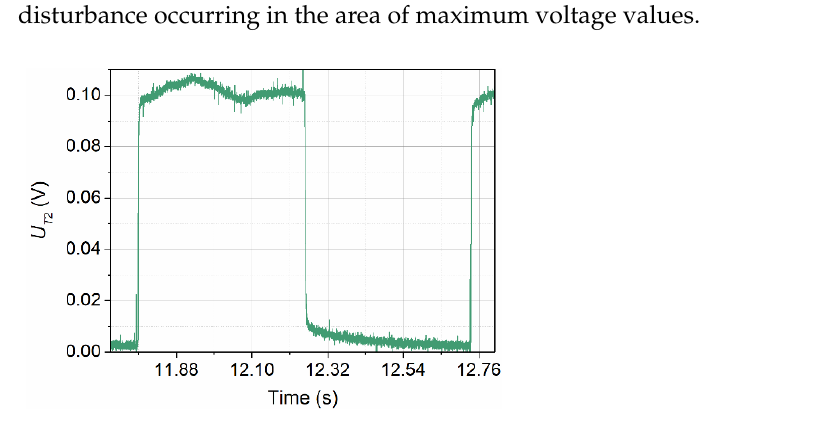
Figure 7. The shape of the pulse recorded by detector T2 for the thermal wave frequency f = 1 Hz and the inflow velocity v ∞ = 1.97 m/s.